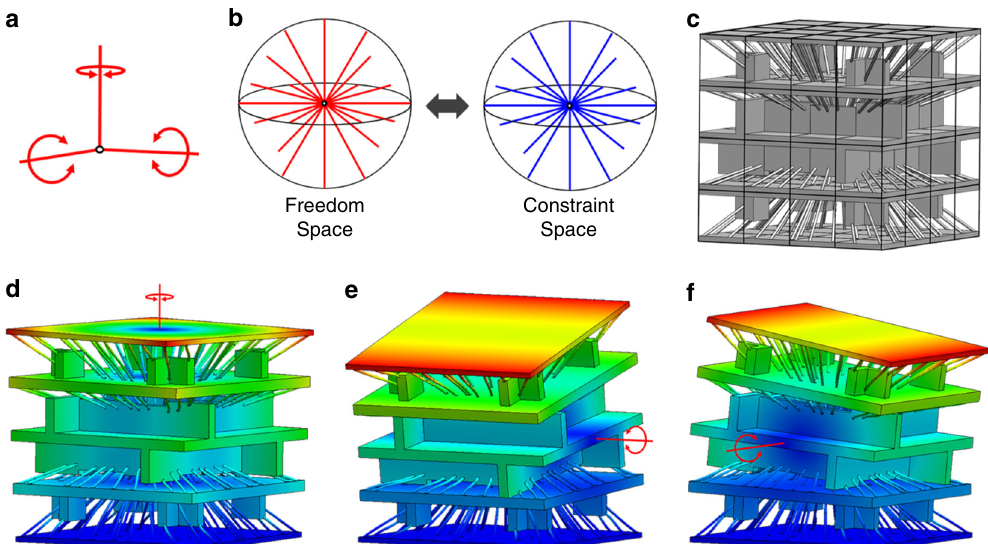
Fig. 5 Example with three intersecting rotational degrees of freedom (DOFs). a Three desired intersecting rotational DOFs and, b the freedom and constraint spaces used to synthesize, c a directionally compliant metamaterial (DCM) that, d – f , achieves the desired compliant rotations (colors in d – f are de fi ned in Fig.